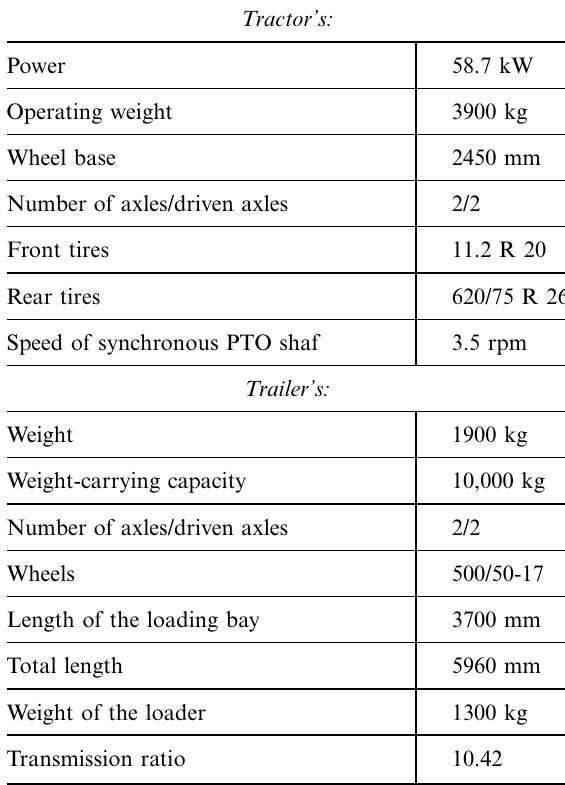
Table 1. Characteristics of the tractor and